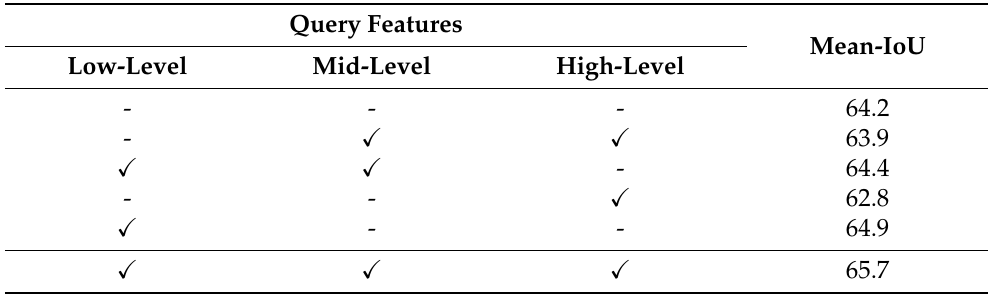
Table 4. Comparison of experimental results of ablation with different number of features cross- connect to decoders on PASCAL-5 i